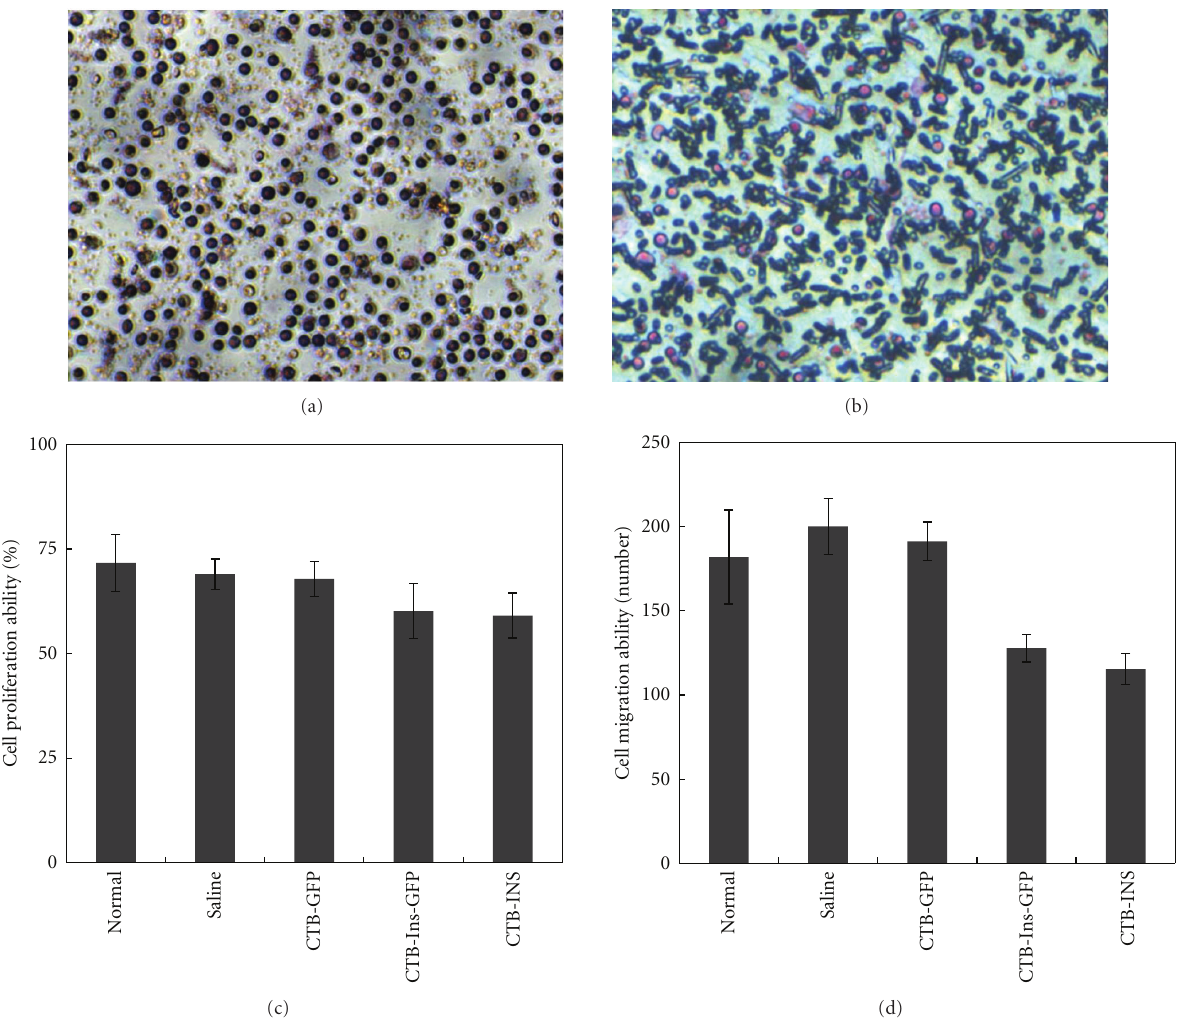
Figure 8: Proliferation and migration abilities of splenocytes in treated NOD mice. Splenocytes (1 × 10 7 cells) isolated from CTB-INS-, CTB- Ins-GFP-, CTB-GFP-, Saline-fed and normal mice at 10 weeks of age were cultured in 24-well plates with 10 μ M BrdU for 24 h. Cells were immunohistochemically stained and examined for stained cell proportions (representative of proliferative ability) according to the protocol. Or splenocytes were cultured in the upper chamber of Transwell plates with 0.6mL of normal culture medium (IL2 150 IU/mL) placed in the bottom chamber at 37 ◦ C with 5% CO 2 for 14 h. The migrated cells were fixed, stained, and numbered under the microscope. A. Splenocyte BrdU assay. Magnification is 400x. (b) Splenocyte Transwell assay. The magnification is 400x. (c) Statistical analysis of proliferative ability. (d) Statistical analysis of migratory ability. All results are presented as the mean titer values ± SD. Five mice per group were tested in two separate